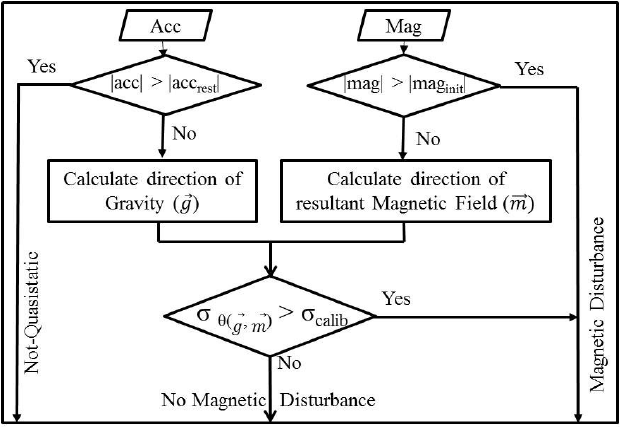
Figure 3. The approach used for magnetic field distortion